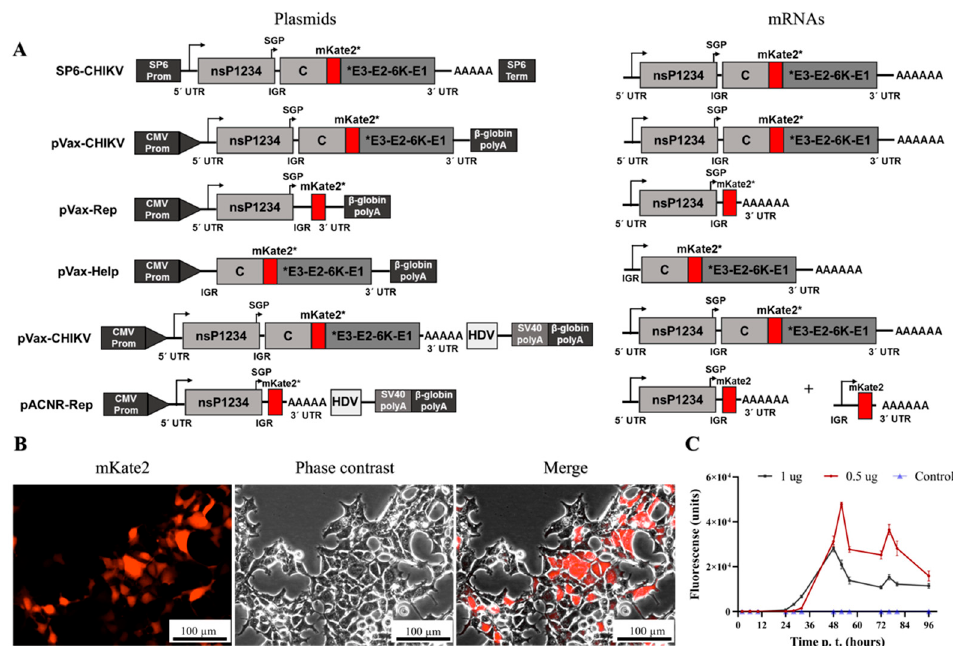
Figure 1. Construction and evaluation of an expression plasmid for CHIKV. ( A ) Schematic repre- sentation of the plasmids generated here. The SP6-CHIKV plasmid is used for in vitro transcription with SP6 polymerase and contains the full-length genome of the attenuated strain 181/25 of the Chikungunya virus. The genomic CHIKV was inserted into the pVax-CHIKV vector from which the human cytomegalovirus (CMV) immediate early enhancer and promoter sequences and β GH polyA derived from pVAX. The SV40 polyA and hepatitis delta virus (HDV) were inserted, and the genome was moved from the pVAX to the vector pACNR1811. The asterisk means that mKate2 is a reporter gene. ( B ) Micrographs of HEK-293T cells transfected with the pACNR-CHIKV plasmid in a fluorescent field (mKate2 channel), phase contrast, and a merge of both. ( C ) Kinetics of the expres- sion of mKate2 from the plasmid pACNR-CHIKV. Bar, 100 µm.